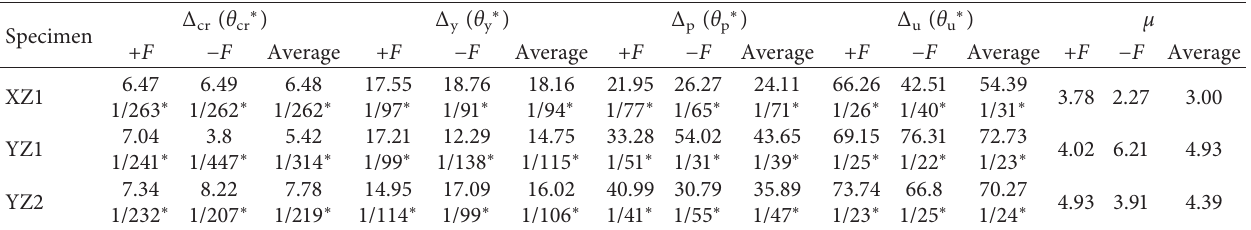
Table 8: Deformation indicators of the specimens at the major characteristic states